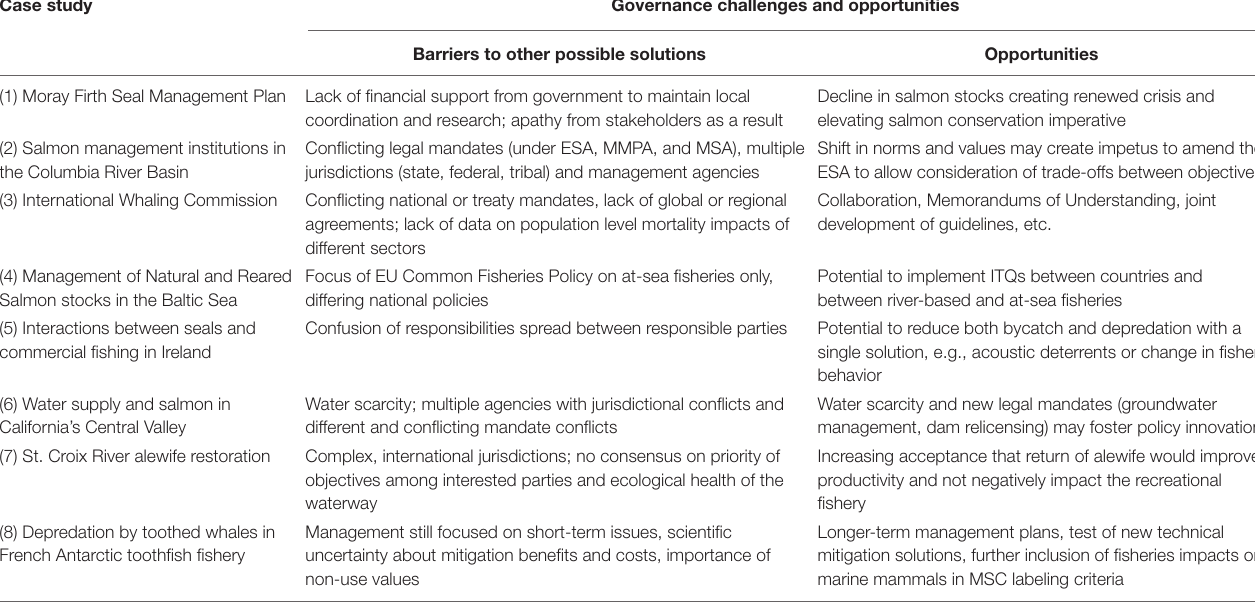
TABLE 8 | Case studies – Governance challenges and